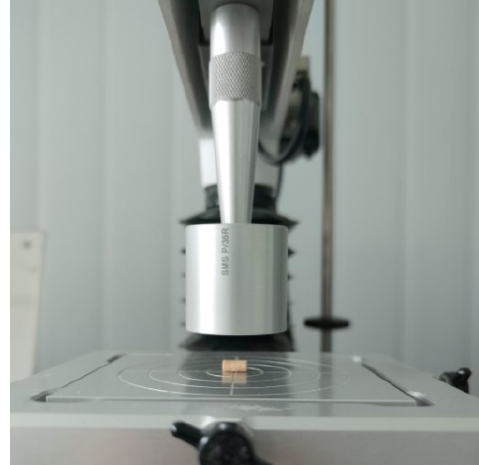
Figure 1. Texture compression experiment.